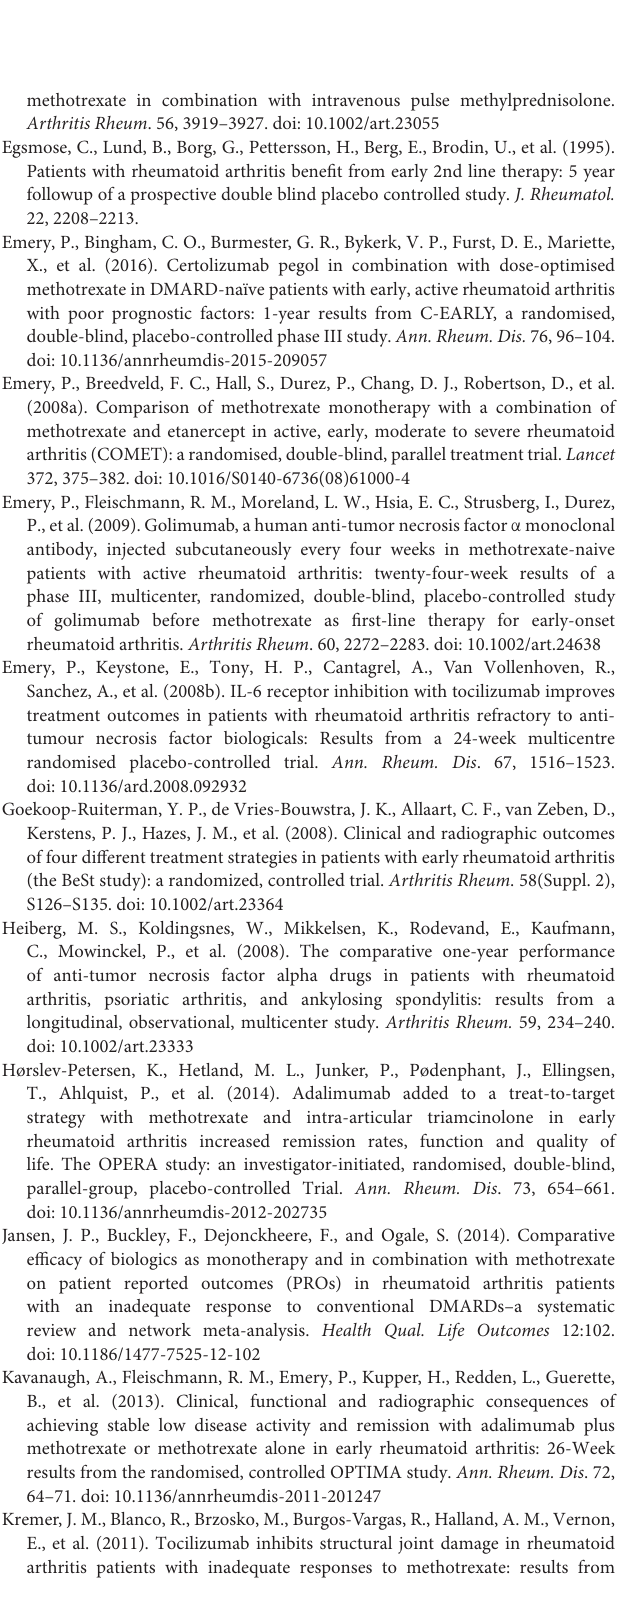
Figure S6 | The results of consistency analysis by note-splitting plot and heat plot of serious adverse